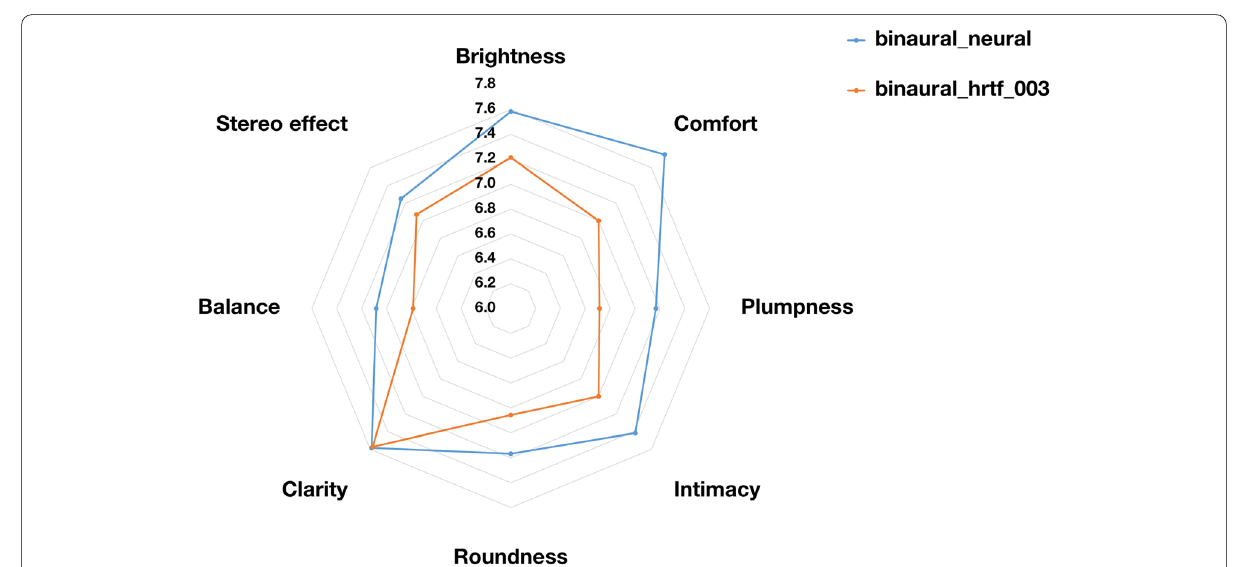
Fig. 9 Results of subjective